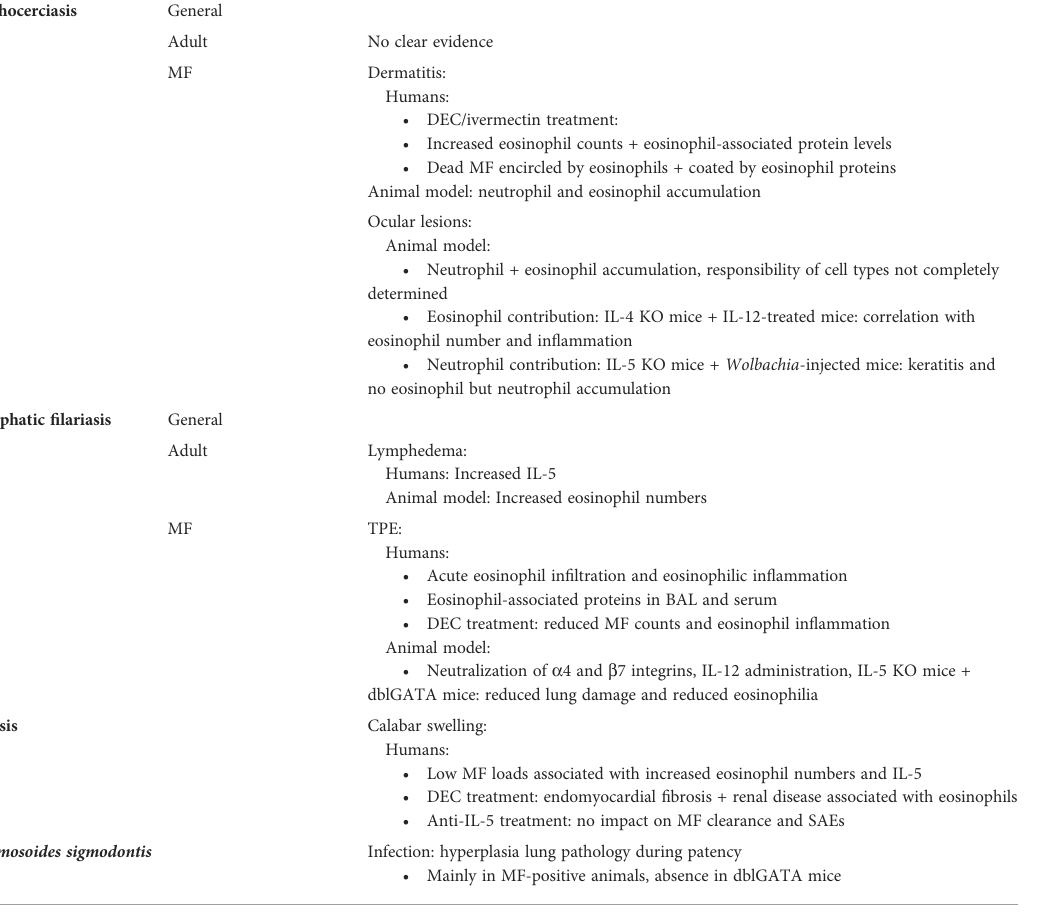
TABLE 4 Summary of eosinophil involvement in pathology development during fi larial